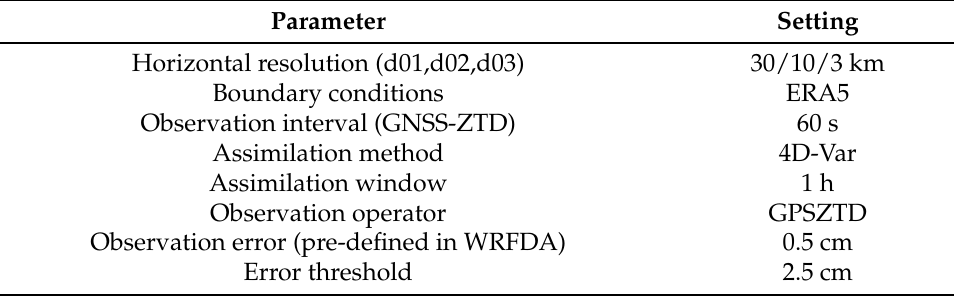
Table 2. Overview of the WRFDA settings chosen for the assimilation